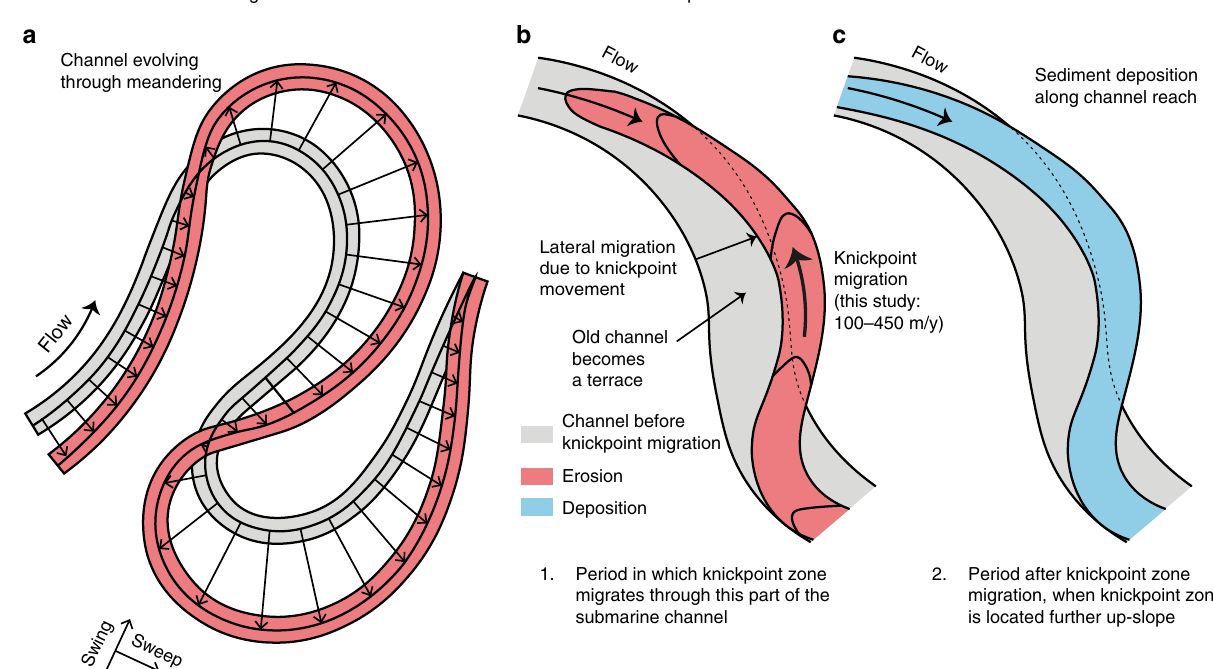
Fig. 8 Comparison between migration of channel bends in meandering rivers and submarine channels dominated by fast-moving knickpoint zones. a Outer-bank erosion leads to swing and sweep of bends in a meandering river (after 30 ). b Rapid knickpoint zone migration in a submarine channel leads to incision, lateral migration, and terrace formation. c ) Knickpoint zone migrates further up-slope, and this part of the submarine channel is then in fi lled by deposition. Deposited sediment is partly sourced from knickpoint erosion occuring further